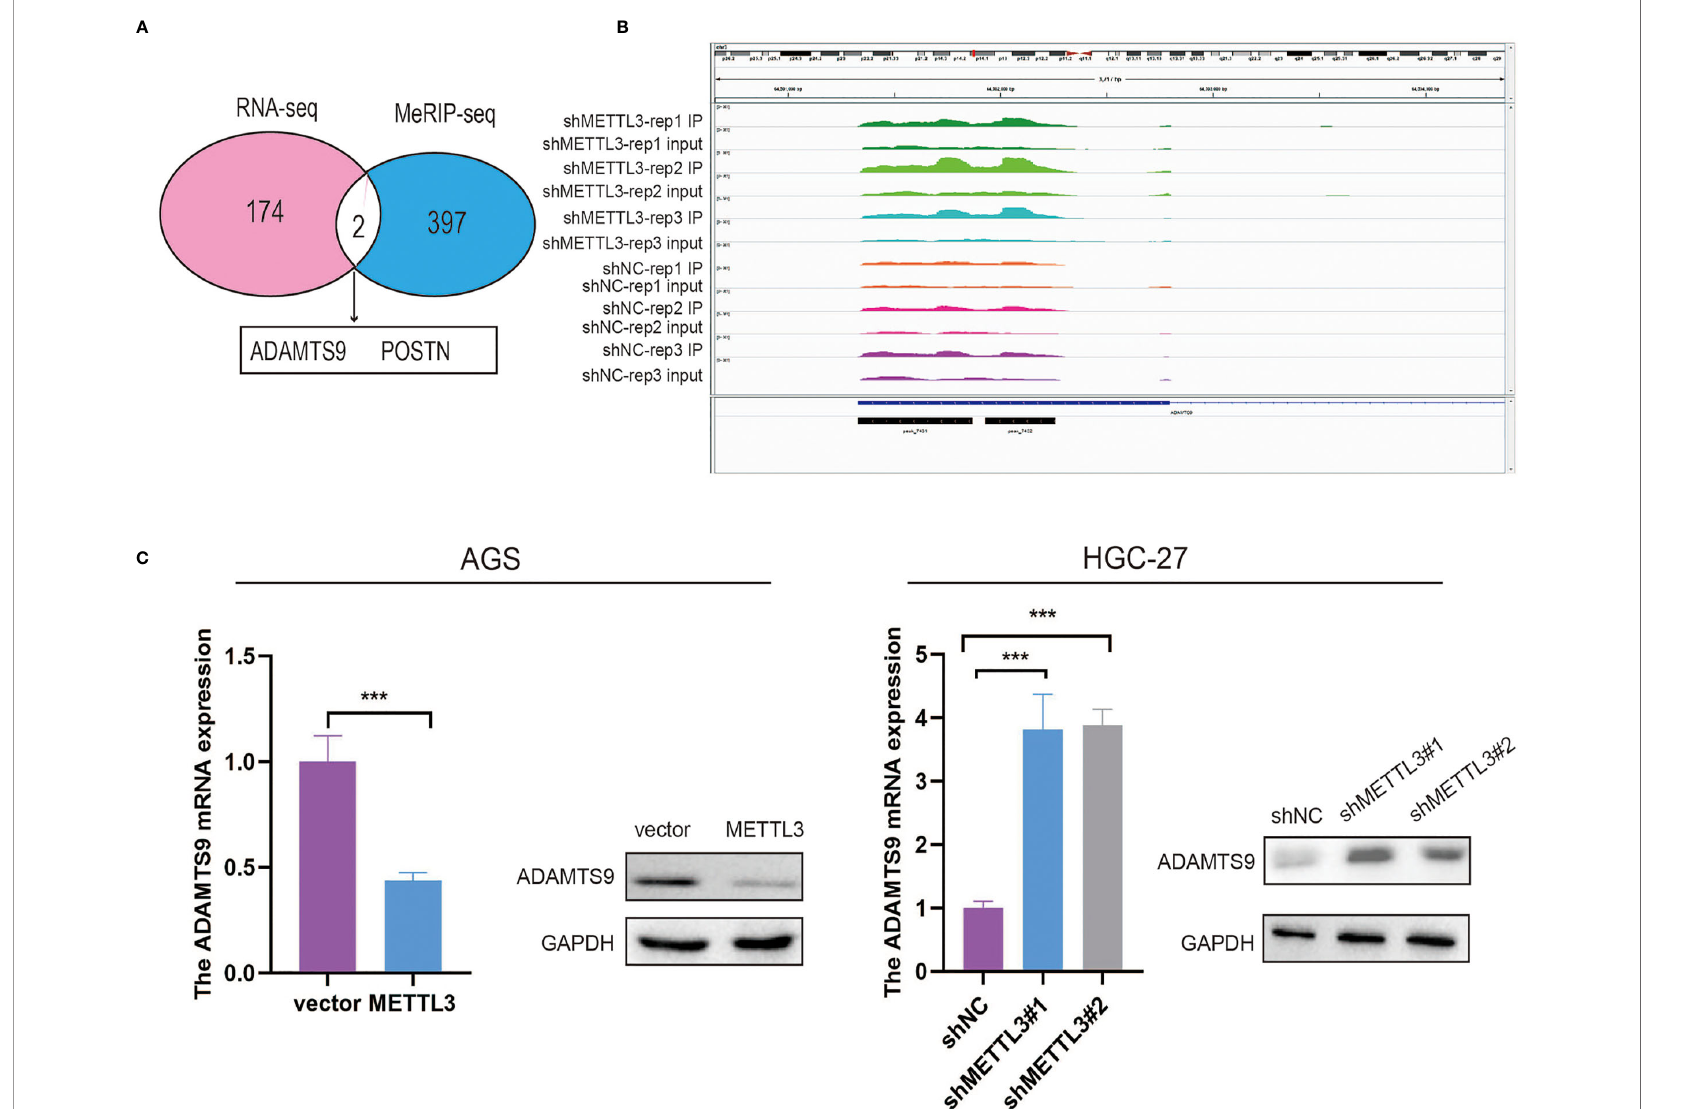
FIGURE 4 | MeRIP-seq and RNA-seq identi fi ed ADAMTS9 as a downstream target of METTL3. (A) ADAMTS9 and POSTN were selected as candidate genes after fi ltering the upregulated genes and reduced m6A peaks. (B) The m6A abundances on ADAMTS9 mRNA in AGS cells with METTL3 knockdown or not as examined by MeRIP-seq were plotted. (C) The expression level of ADAMTS9 in METTL3-deci fi cent and -overexpression GC cells. ***P <